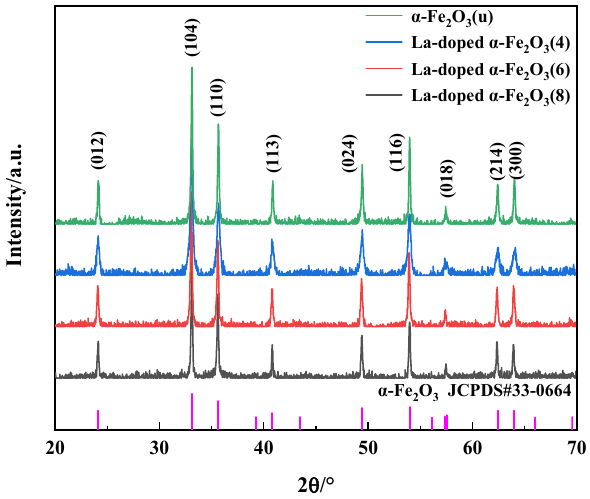
Figure 1. XRD patterns of α -Fe 2 O 3 (u) and La-doped α -Fe 2 O 3 (x) (x = 4, 6, 8). Table 2. Average crystal size and lattice constant of nanoparticles.